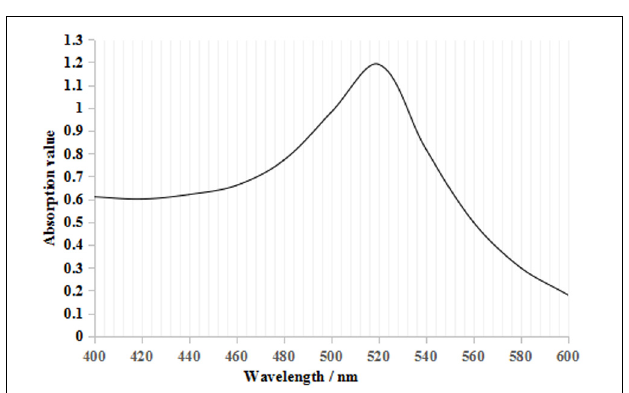
FIGURE 2 | Colloidal gold UV–visible scanning curve. There was only one maximum absorption value at 520 nm, which is the characteristic absorbance peak for colloidal